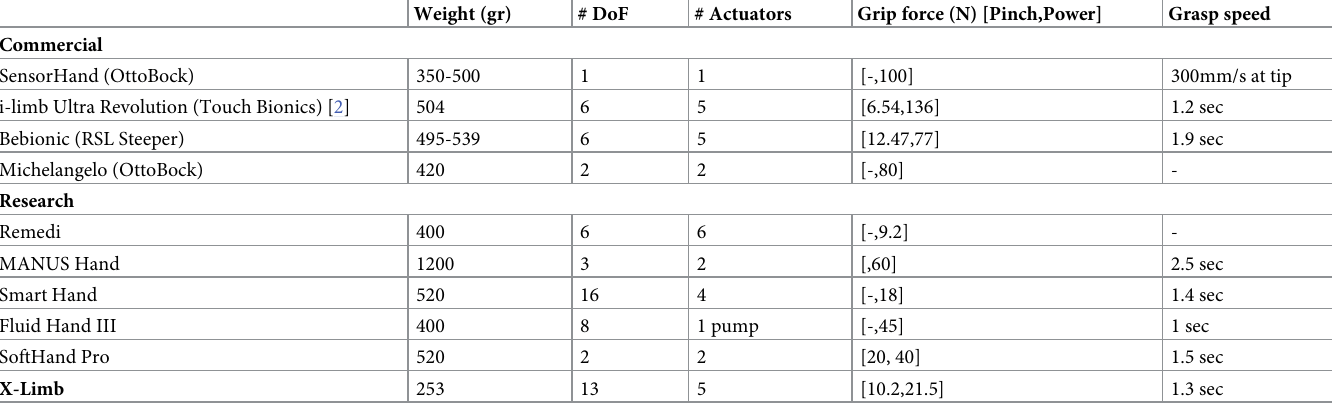
Table 3. Characteristics of the proposed design (X-Limb) and other anthropomorphic commercial and research myoelectric hand prostheses with intrinsic actu- ation